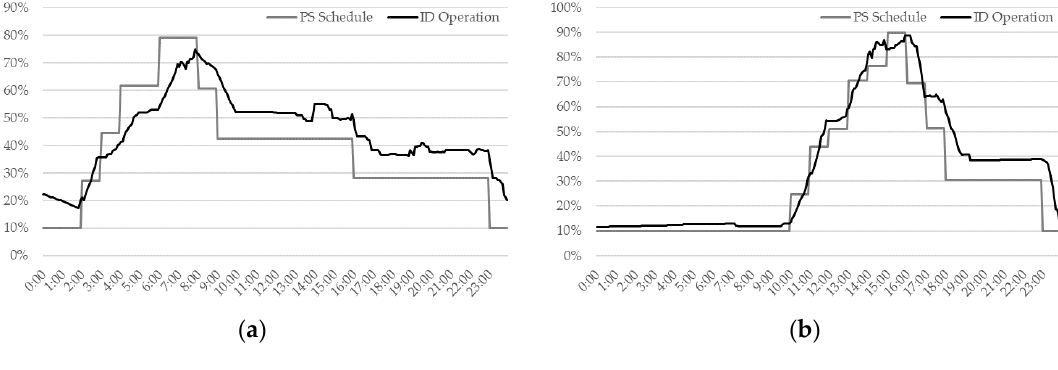
Figure 10. PS schedule and result of ID operation scheduling method of ( a ) an independent ESS and ( b ) a combined ESS.